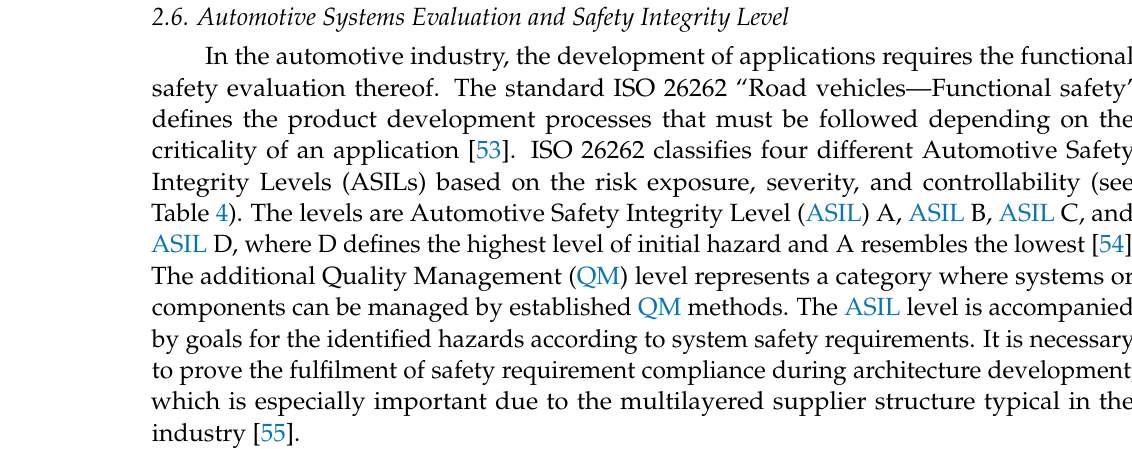
Figure 3. Updated evolution of medical device cybersecurity regulations based on